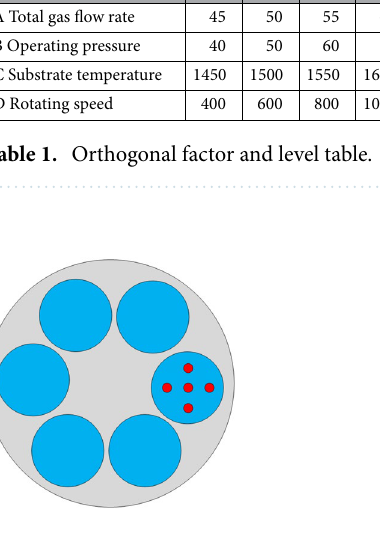
Figure 3. 5-point positions schematic